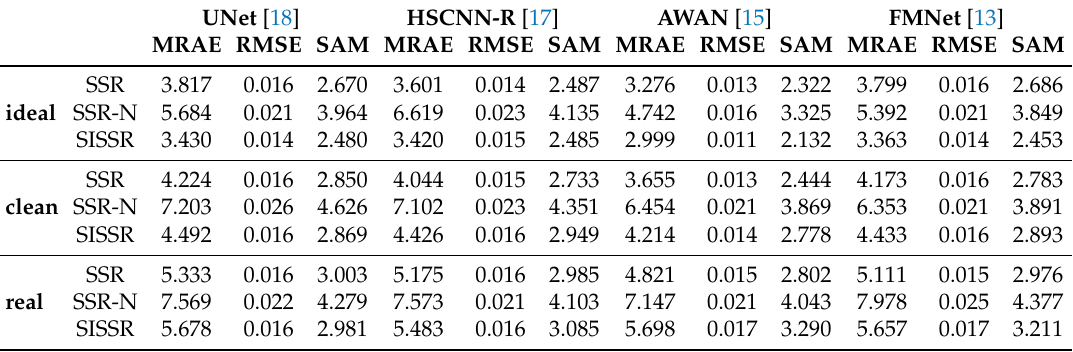
Table 2. Average reconstruction metrics over the test set, which equals the official validation split of the NTIRE 2020 challenge on spectral reconstruction [11]. Spectral angle mapper (SAM) is reported in degree, mean relative absolute error (MRAE) in